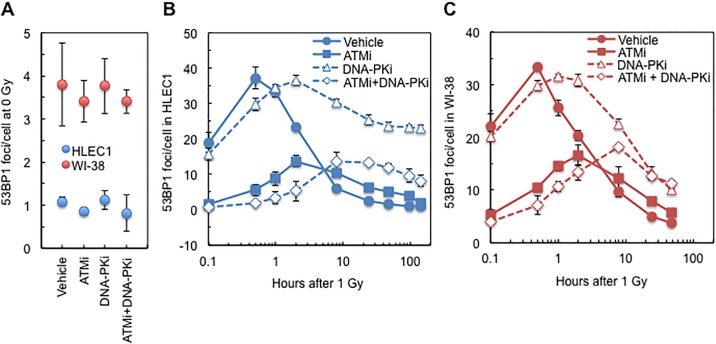
Effect of a continuous treatment with ATMi and/or DNA-PKi on temporal kinetics of 53BP1 focus formation at 0.1, 0.5, 1, 2, 8, 24, 48, 96 or 144 h after 1 Gy irradiation.(A) HLEC1 and WI-38 after sham irradiation. (B) HLEC1 after 1 Gy irradiation. (C) WI-38 after 1 Gy irradiation. For HLEC1 and WI-38, CPD at the time of irradiation was 14.1 ± 0.3 and 39.9 ± 0.4, and dose rate was 0.44 ± 0.00 and 0.43 ± 0.00 Gy/min, respectively. Inhibitors were added at 0.5–1 h prior to irradiation and continued to exist until cells were fixed at indicated times postirradiation. Data represent means and SDs of three independent experiments, where 100–318 cells were counted for each sample.